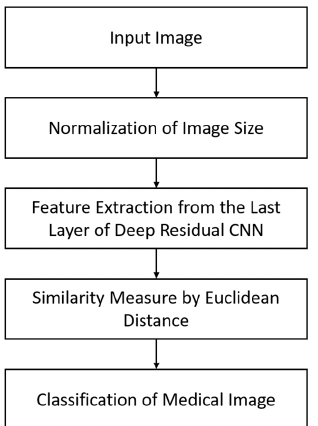
Figure 1. Overall procedure of the proposed method for classification.